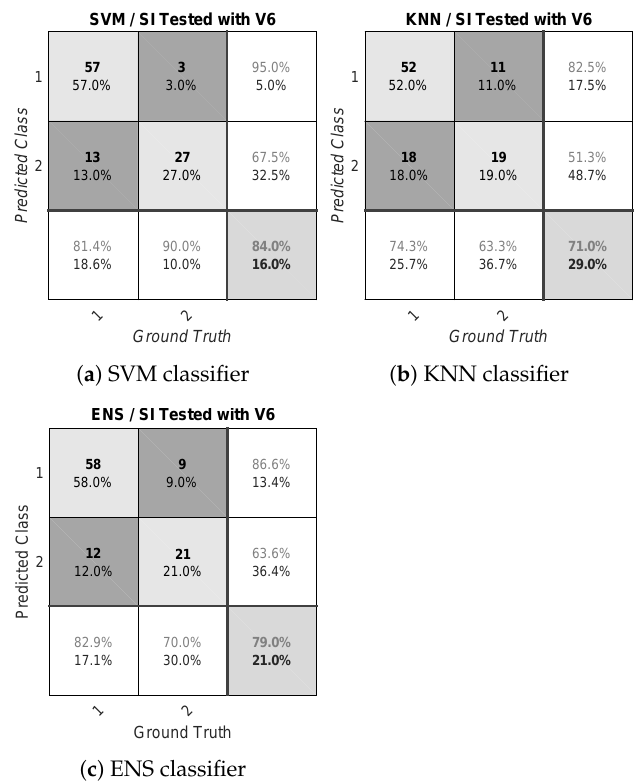
Figure A16. Confusion matrices for a subject-independent model tested with